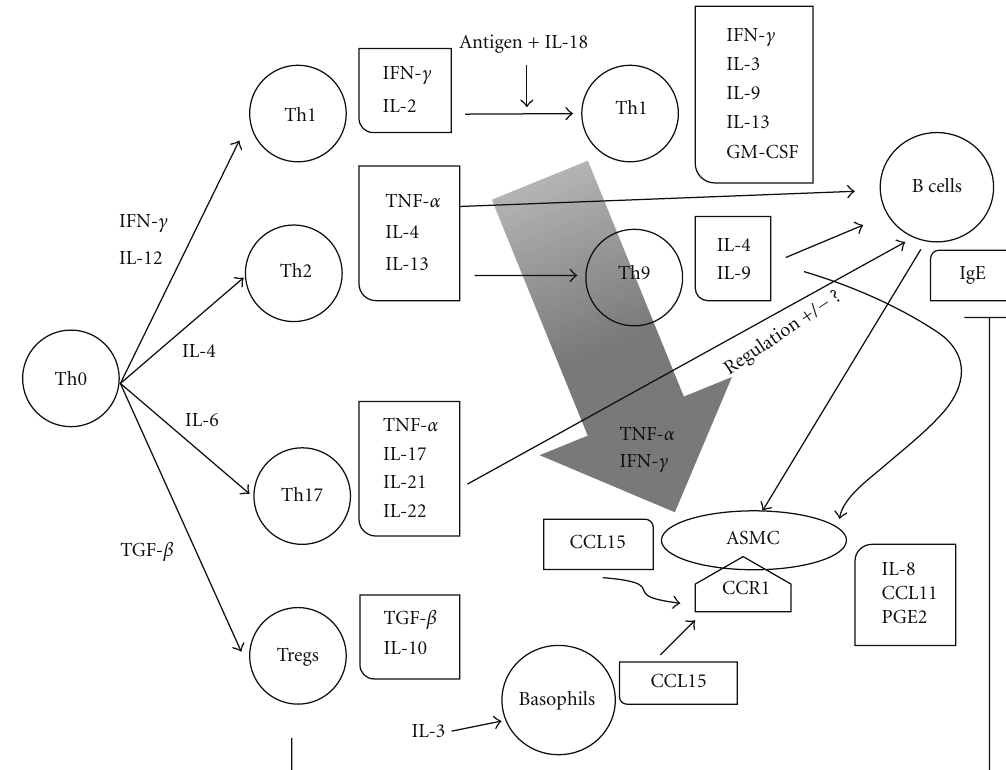
Figure 2: CD4+ Th subsets in asthma and the potential role of CCL15 production by ASMC. Mixed Th1 cells produce both Th1 and Th2 cytokines (IFN- γ , IL-3, IL-9, IL-13, GM-CSF) when stimulated by exposure to an antigen plus IL-18. Th2 and Th17 cells secrete TNF- α , while Th9 cells are di ff erentiated from Th2 cells secrete IL-9, which promotes IgE production by B cells and the production of IL-8, CCL11, and prostaglandin E 2 (PGE 2 ) by ASMC. IgE promotes the inflammatory phenotype of ASMC, and these cells produce CCL15 when stimulated with both TNF- α and IFN- γ . IL-21 from Th17 cells has been suggested to regulate IgE production by B cells, and Tregs have an inhibitory e ff ect on